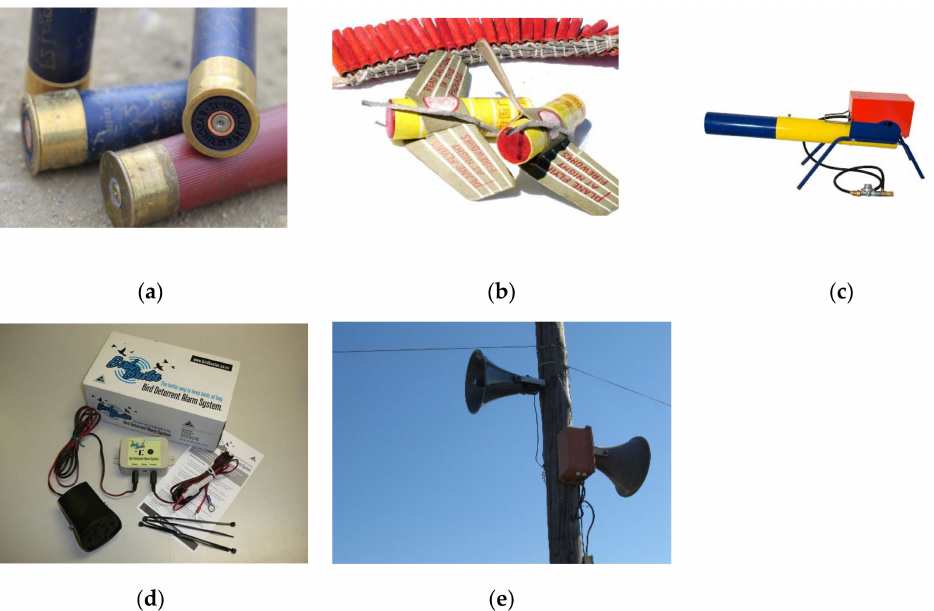
Figure 2. Auditory deterrents: ( a ) shotgun ammunition; ( b ) pyrotechnics; ( c ) gas cannon; ( d ) AV- alarm; ( e ) predator sounds, high sounds, ultrasound, and